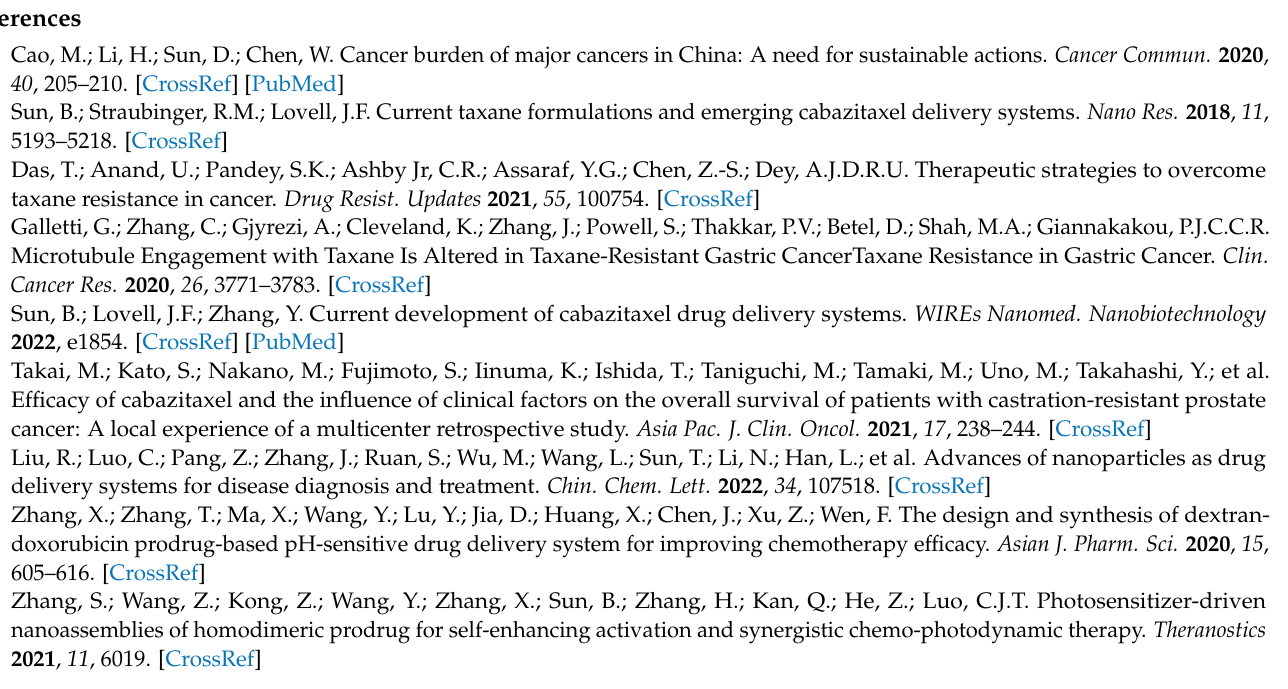
SAC; Figure S3: (A) 1 H NMR; 13 C NMR and (C) MS of SBC; Figure S4: (A) 1 H NMR; 13 C NMR and (C) MS of SGC; Figure S5: Molar concentration-time curves of SBC NPs with different amounts of PEG ( w / w ); Figure S6: The appearance of three nanoassemblies at concentrations of 1 mg/mL; Figure S7: In vivo antitumor activity of prodrug nanoassemblies against 4T1 xenograft tumors ( n = 5). Image of tumors after last treatment. (Scale bar represents 1 cm); Figure, S.8:; Hemolysis, of SAC NPs (A), SBC NPs (B), SGC NPs (C), CTX solution (D), positive control (E) and negative control (F) at 4 h; Figure S9: Representative H&E-stainings of major organs (heart, liver, spleen, lung and kidney) after the last treatments; Table S1: Characterization of PEGylated prodrug nanoassemblies. Data are presented as the mean ± SD ( n = 3); Table S2: IC 50 (ng/mL) of CTX solution and prodrug NPs in 4T1 and 3T3 cells. Data are presented as the mean ± SD ( n = 3); Table S3: The tumor-selective index (SI) of CTX solution and prodrug nanoassemblies between normal cells and tumor cells; Table S4: Pharmacokinetic parameters of CTX solution and prodrug nanoassemblies. Data are pre- sented as mean ± SD ( n = 5); Table S5: The hemolysis rate of CTX solution, SAC NPs, SBC NPs and SGC NPs at 2 h, 4 h and 6